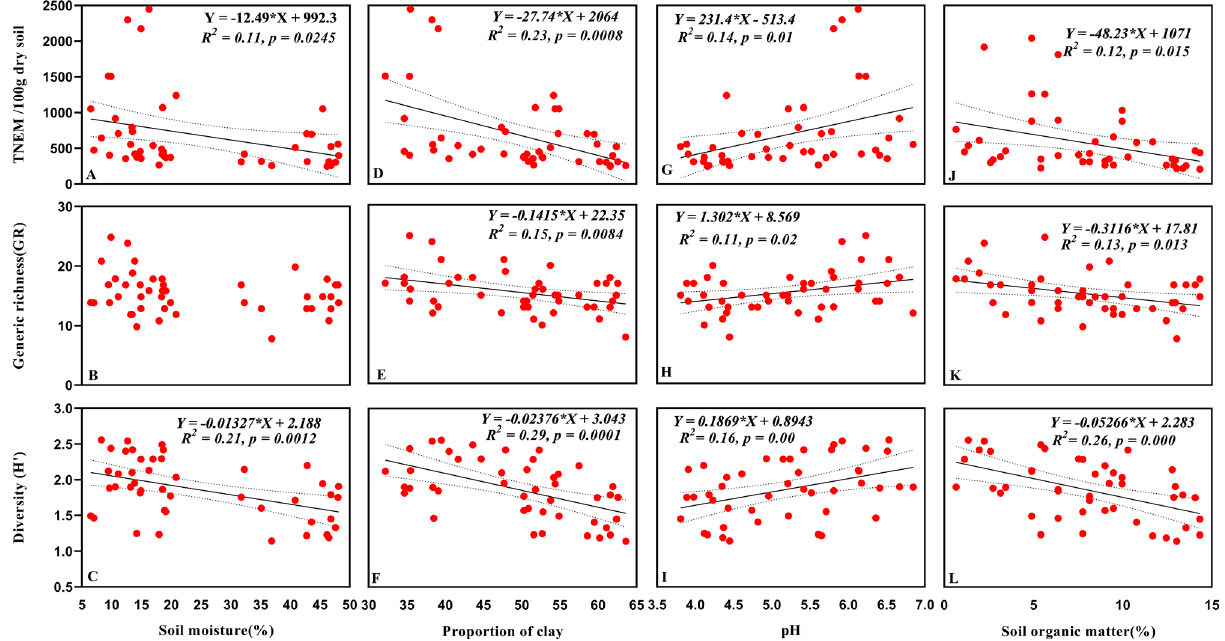
Figure 8. Relationship of soil moisture, proportion of clay, pH and soil organic matter with total nematode abundance, GR and H ′ ( A – L ). Equation for Y , R 2 (coefficient of determination), p (significance) of linear regression, regression line and dotted lines of 95% of confidence interval are displayed only for significant relationships.